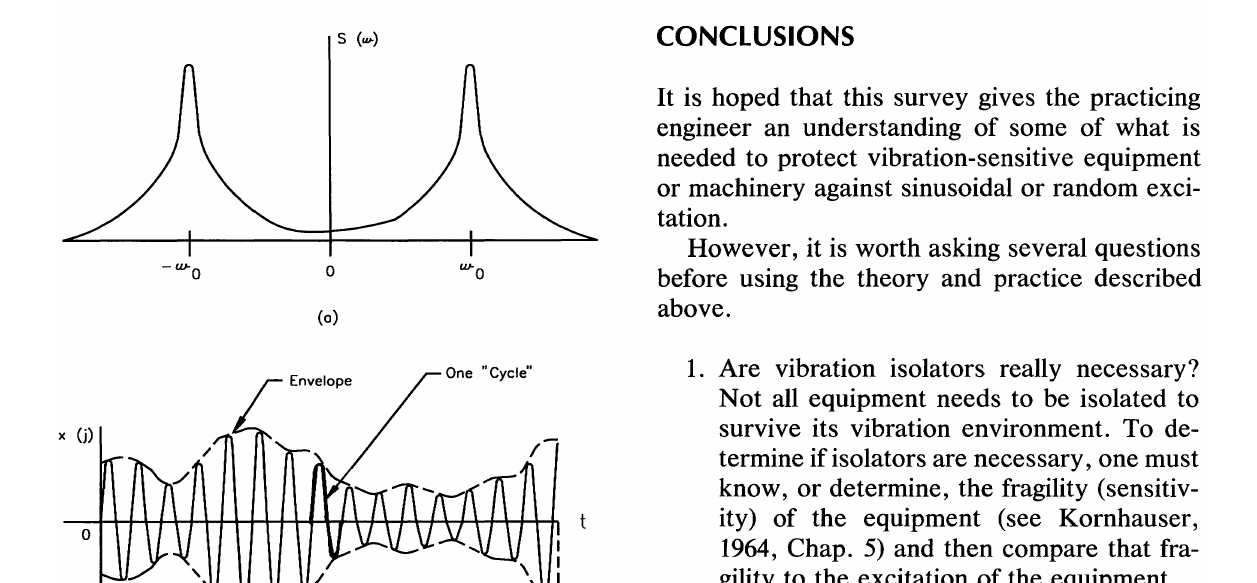
FIGURE 13 (a) Two-side PSD of a narrow-band ran dom process; (b) time history of a narrow-band ran dom process. Used by permission from Crandall and Mark (1963).